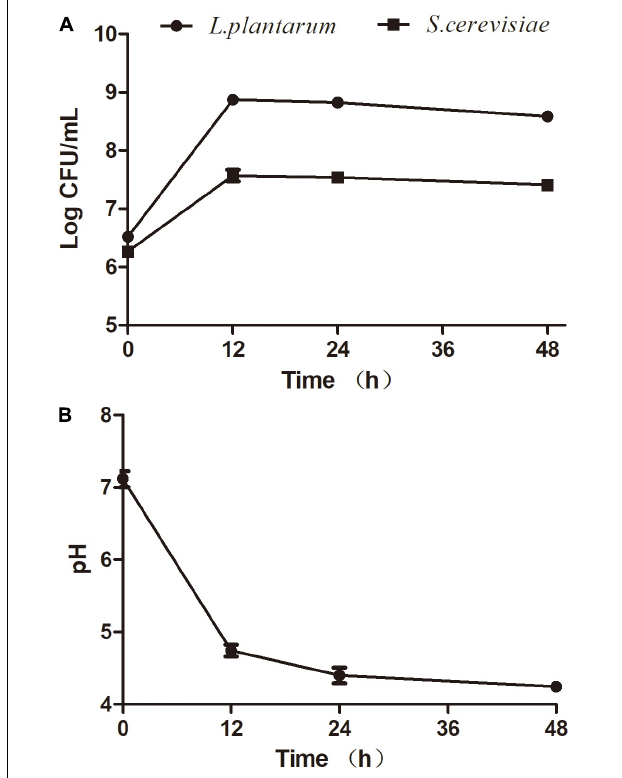
FIGURE 1 | Fermentation activity of S. cerevisiae (AMnb091) and L. plantarum (LP1406) during co-culture fermentation of seaweed extracts. (A) Cell growth, (B) pH. Data are expressed in terms of means ± SD.